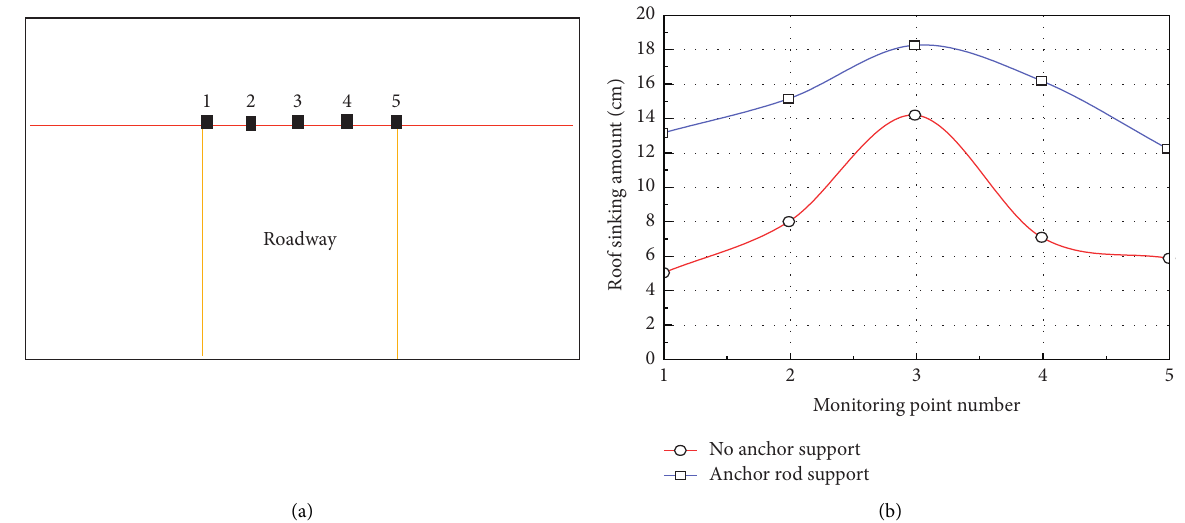
Figure 7: Monitoring point at roof and subsidence of roof: (a) layout of roof monitoring points; (b) roof subsidence